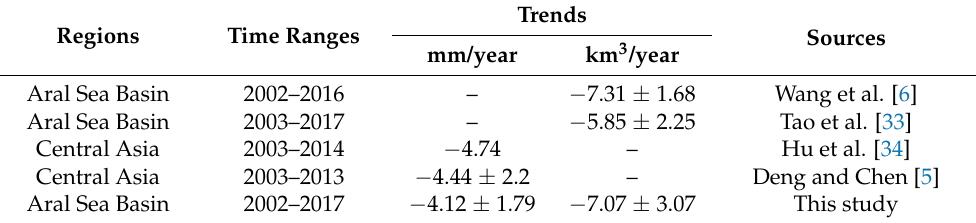
Figure 4. The variations in TWSA and precipitation ( a ), and year-to-year variations in monthly TWSA ( b ) of the Aral Sea Basin during the period of April 2002 to June 2017. In ( a ), the blue bars represent the data uncertainty. In ( b ), the red horizontal lines represent the month’s median TWSA, the blue dots represent the month’s average TWSA, the boxes represent the inner-quartile range, and the whiskers represent the full range of the data. Table 2. Comparisons of the variation trend in TWSA of the Aral Sea Basin with the results observed in previous